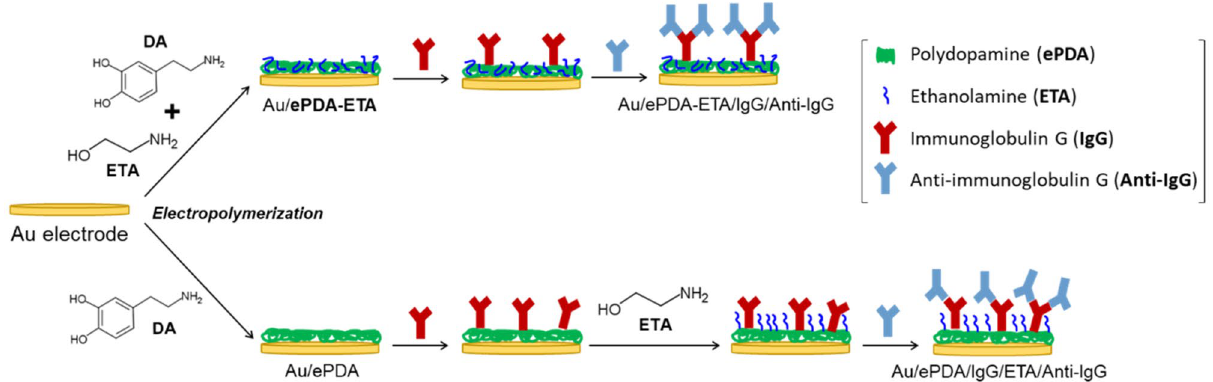
Figure 1. Schematic illustration of the gold modification steps for the construction of the polydopamine- ethanolamine immunosensing interface, using one-step or post-modification